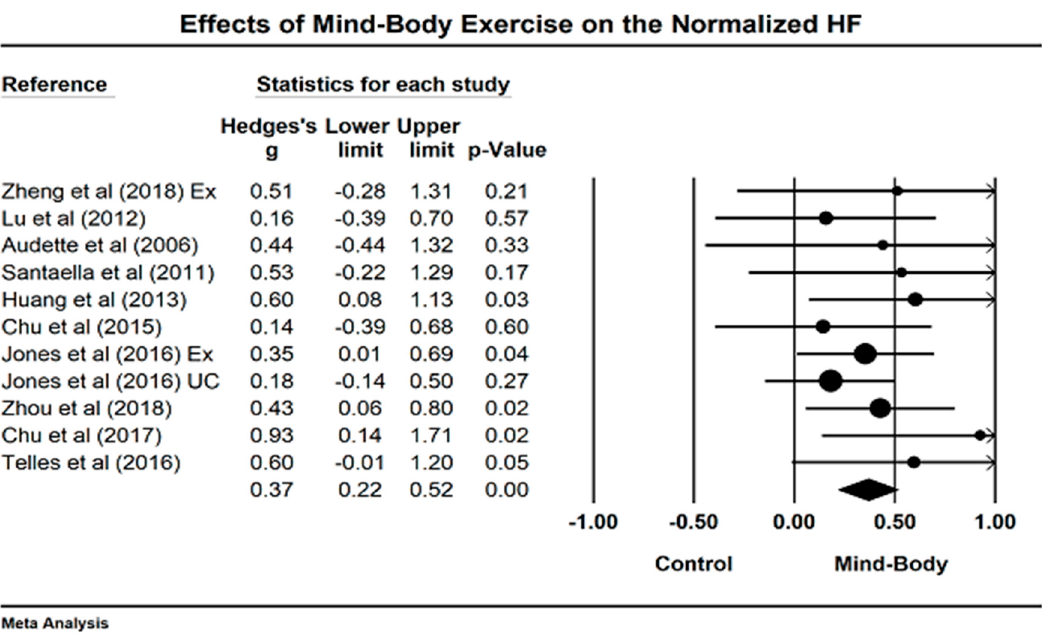
Figure 5. Effects of mind–body exercise on the normalized high-frequency power (Ex = exercise control, UC = usual care).